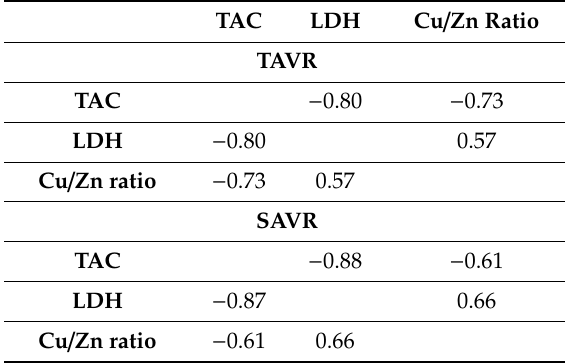
Table 3. Correlation coe ffi cients ( r values) between examined oxidative stress markers assessed post-procedures (the first post-procedural